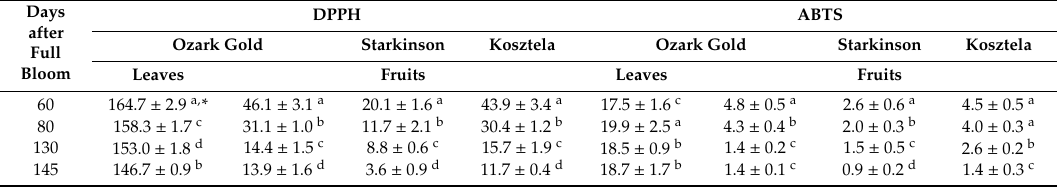
Table 4. Change in the antioxidant capacity (mM Trolox / g dw) during the developing and ripening of the fruits and